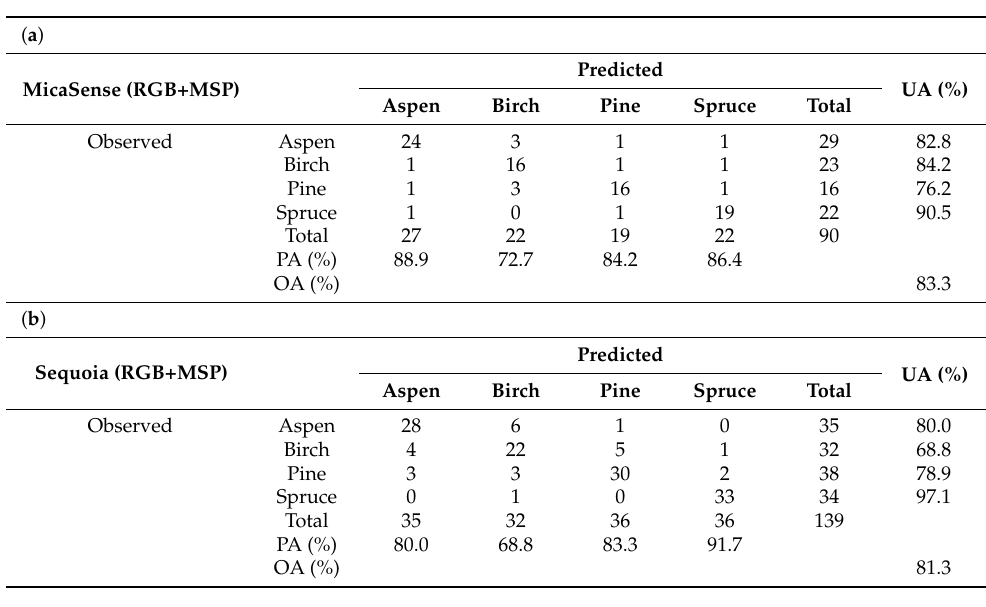
Table 5. Confusion matrix for the best SVM model for a) the MicaSense dataset (MSP and RGB features) and b) the Sequoia dataset (MSP and RGB features). UA = user’s accuracy, PA = producer’s accuracy, OA = overall